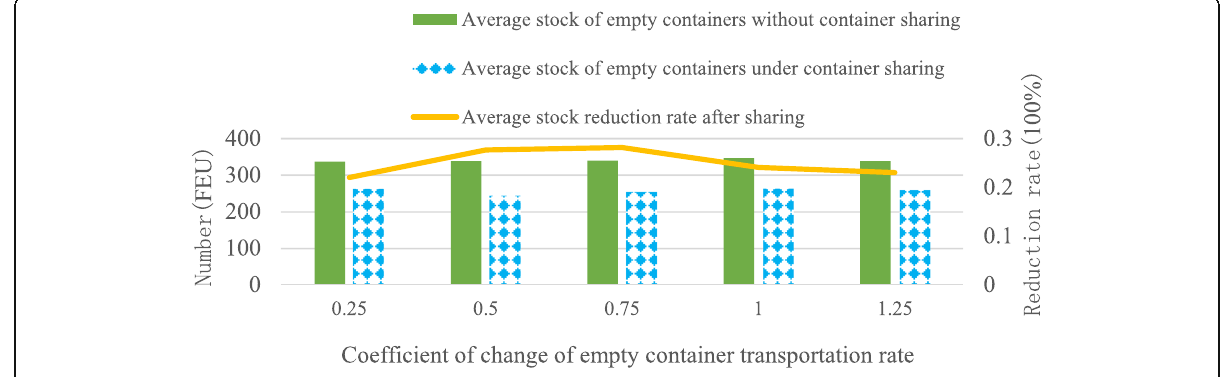
Fig. 4 Impact of empty container transportation rate change on the average empty container